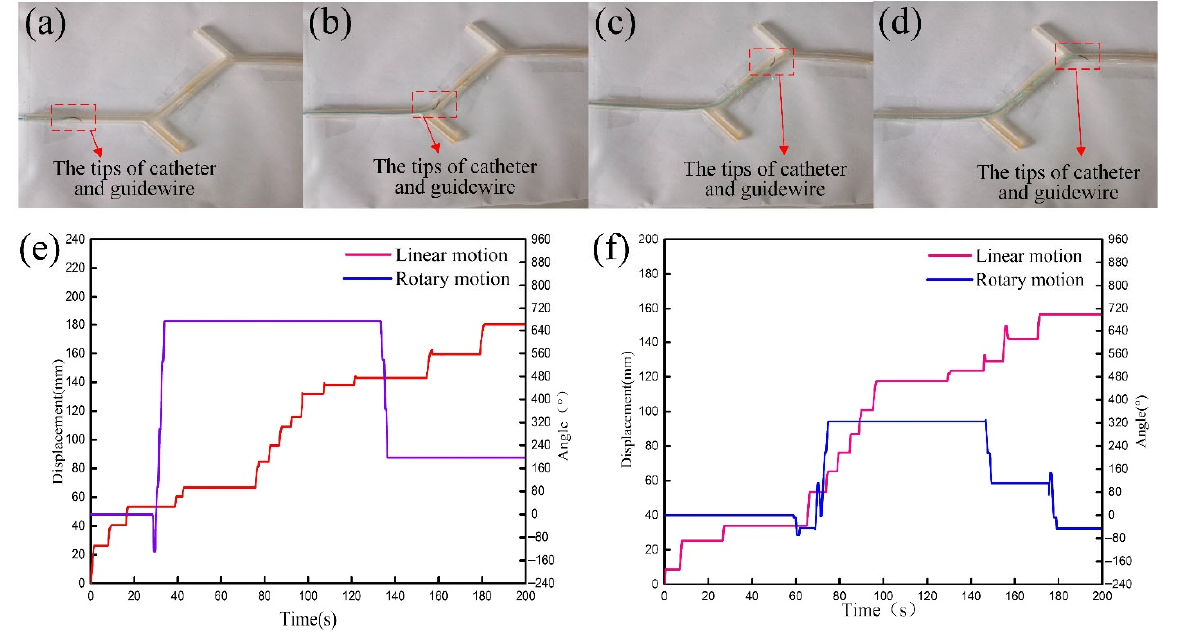
Figure 12. The movement of guidewire and catheter ( a – d ). The linear displacement and rotary angle of the GM ( e ) and CM ( f ).